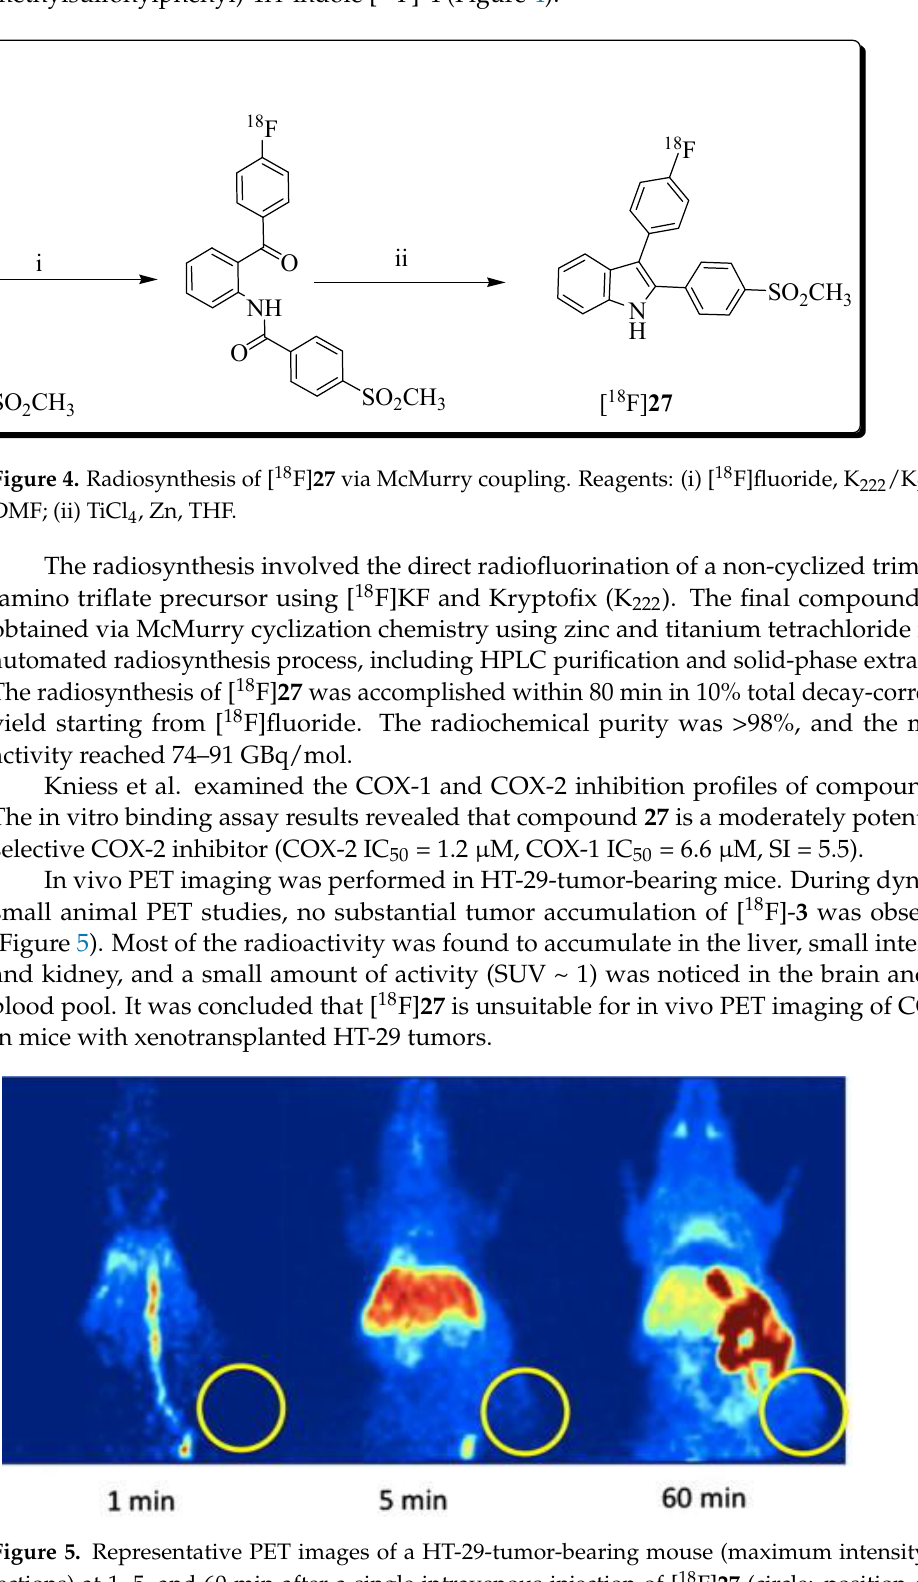
Figure 5. Representative PET images of a HT-29-tumor-bearing mouse (maximum intensity projections) at 1, 5, and 60 min after a single intravenous injection of [ 18 F] 27 (circle: position of the subcutaneously xenotransplanted tumor). Figure readapted with permission from publisher [74].